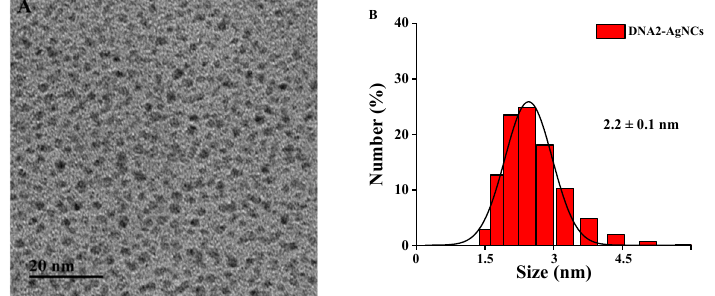
Figure 5. ( A ) TEM image of the DNA2-Ag NCs. ( B ) Particle size distribution histogram of the DNA2-Ag NCs.